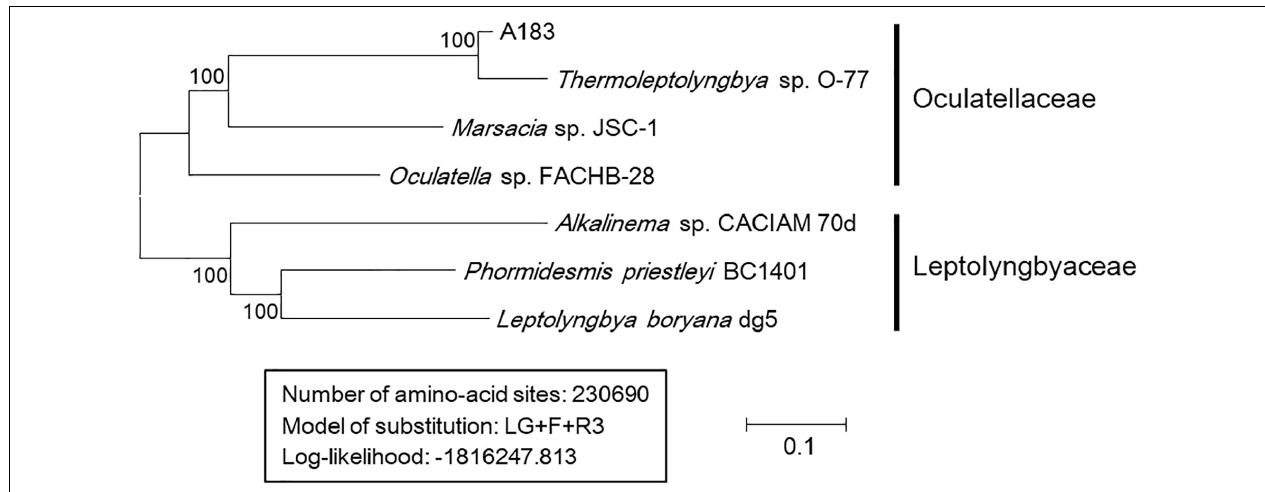
FIGURE 6 | Maximum-likelihood phylogenomic tree of concatenated protein alignment of 751 single-copy genes shared by all genomes. Bootstrap values (1000 replications) are indicated at nodes. Scale bar = 10% substitutions per site.